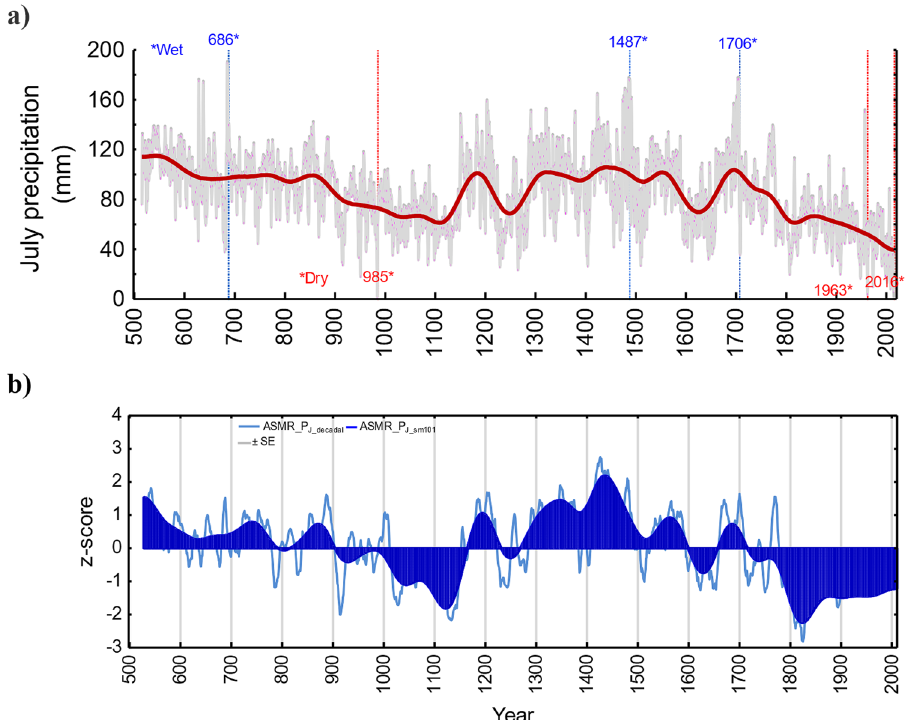
Figure 2. A newly reconstructed annually-resolved July precipitation chronology was derived from the δ 13 C cell for the period from 516 to 2016 CE. Standard errors (SE + and SE−) presented in a grey color ( a ) and a newly developed regional ASMR—July precipitation reconstruction (ASMR-P J ) based on the combination of δ 13 C cell, Rb/Sr and Co/Inc (Eq. 7) for the period from 529 to 2010 CE ( b ). All chronologies are smoothed by a 101-year Hamming